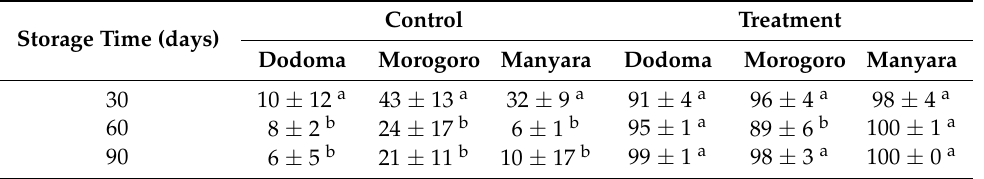
Table 3. Effect of physical disturbance on mortality rate (%) of S. zeamais .